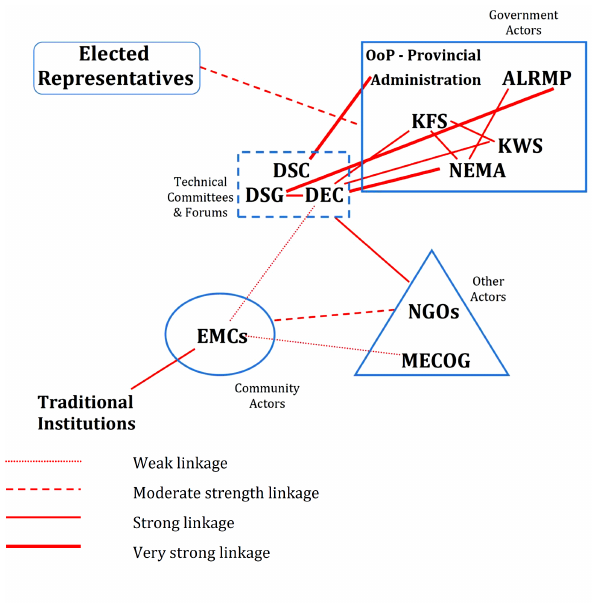
Fig. 2 . Key institutional linkages in the governance